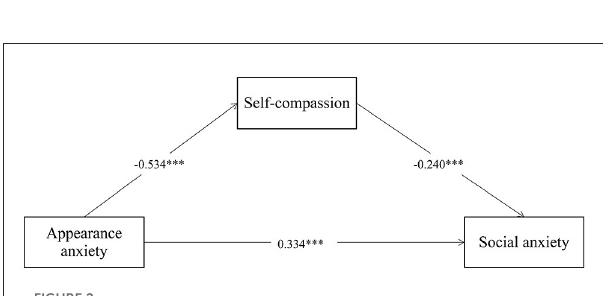
FIGURE2 The mediated model. *** p <